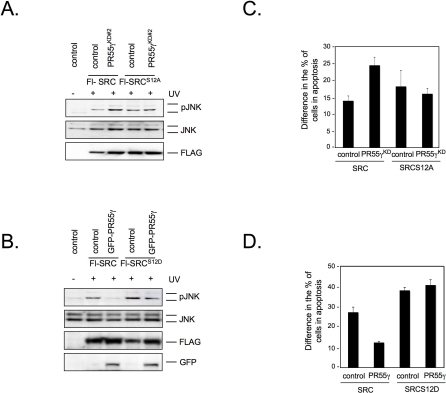
Inhibition of JNK Activity by PR55γ Is Dependent upon Ser12 of c-SRC(A) PR55γKD2 vector or control vector were cotransfected as indicated in the presence of FLAG-SRC or FLAG- SRCS12A. Selected cells were exposed to UV irradiation and whole cell extracts were analyzed by immunoblotting with antibodies targeting phosphorylated JNK (α-pJNK), JNK1 and JNK2 (α-JNK), or FLAG (α-FLAG).(B) GFP-PR55γ vector or control vector were cotransfected as indicated in the presence of FLAG-SRC or FLAG- SRCS12D. Selected cells were exposed to UV irradiation and whole cell extracts were analyzed by immunoblotting with antibodies targeting phosphorylated JNK (α- pJNK), JNK1 and JNK2 (α-JNK), FLAG (α-FLAG), or GFP (α-GFP).(C) U2-OS cells coexpressing PR55γ shRNAs and FLAG-SRC or FLAG- SRCS12A as indicated. Selected cells were exposed to UV irradiation (50 J/m2) and treated 18 h later with fluorescent dye measuring mitochondria membrane potential (DiOC6[3]). Figure represents three independent experiments.(D) U2-OS cells expressing PR55γ and FLAG-SRC or FLAG- SRCS12D as indicated. Selected cells were exposed to UV irradiation (50 J/m2) and treated 18 h later with fluorescent dye measuring mitochondria membrane potential (DiOC6[3]). Figure represents three independent experiments.doi:10.1371/journal.pgen.0030218.g008